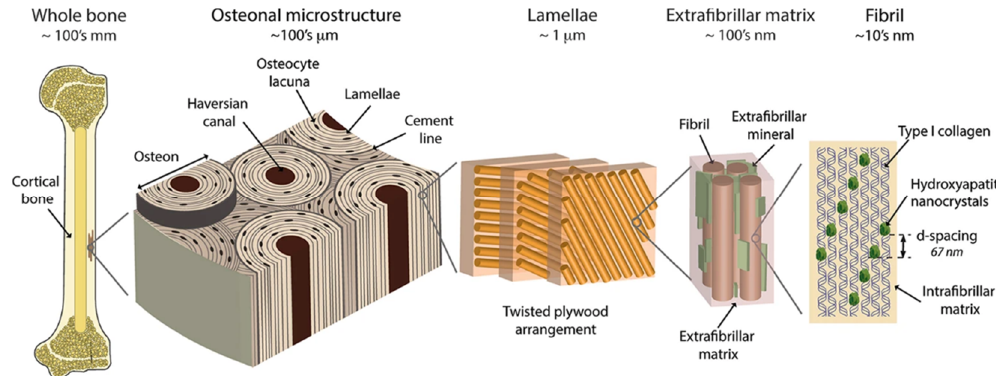
Figure 2. The hierarchical organization of cortical bone. On the first level, there are fibrils (~10 nm thick), composed of parallel aligned type I collagen strands, mineralized with evenly distributed hydroxyapatite crystals. Those fibrils are arranged in bundles, surrounded by extrafibrillar mineralized platelets. The bundles, arranged in the plywood-like structure form lamellae, where adjacent lamellae may have different orientation of bundles. The layers of concentrically aligned lamellae surrounding the Haversian canal forms a basic structural unit of bone—osteon (170–250 μm in diameter). Taken from [39].